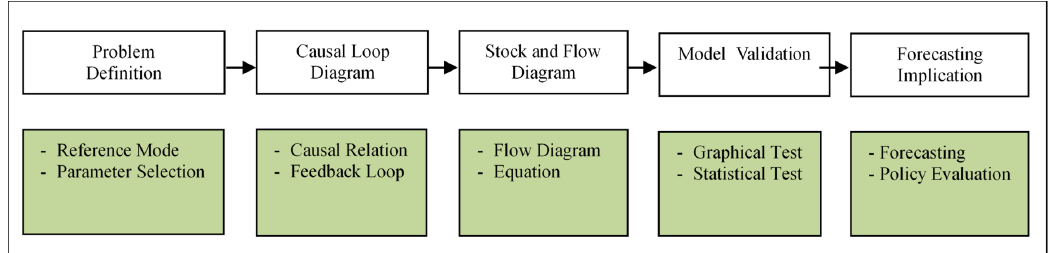
Figure 1. Research framework.